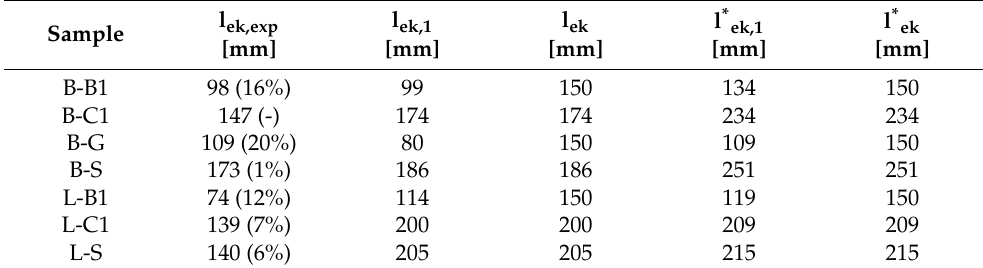
Table 8. The values of effective bond